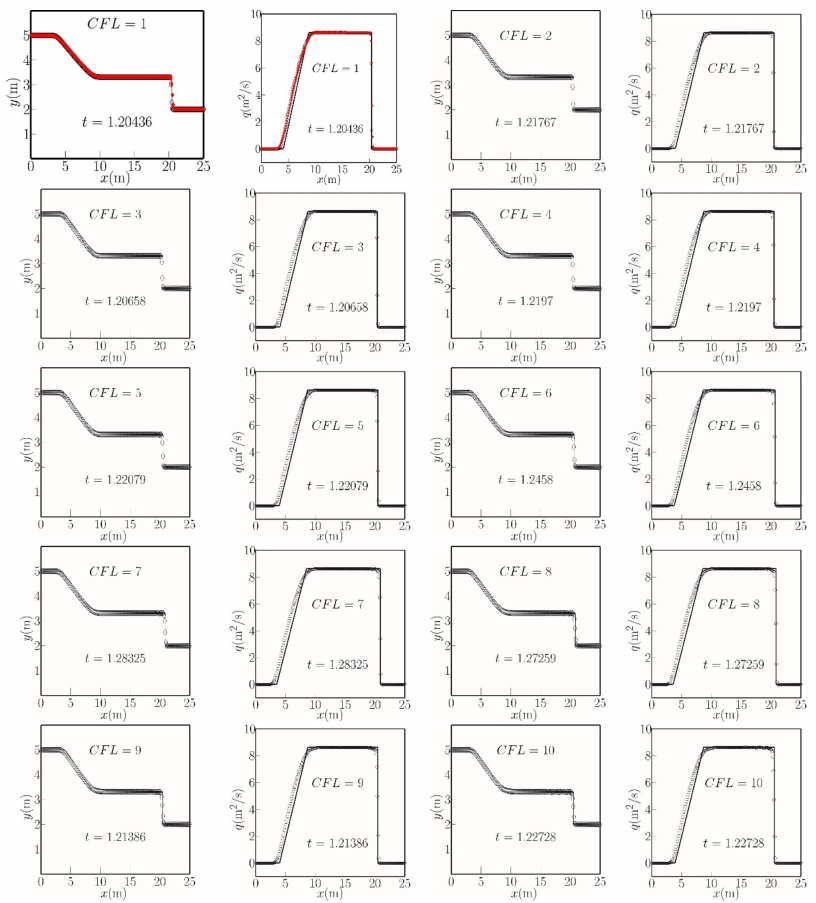
Figure 3. Free surface and mass flux profiles for one rarefaction and one shock in a frictionless, horizontal channel at a given time instant. Toro’s [2] almost exact solution (solid lines), Roe’s [3] scheme (red circle), and TVD-LTS predictions (open circles) for CFL = 1 to